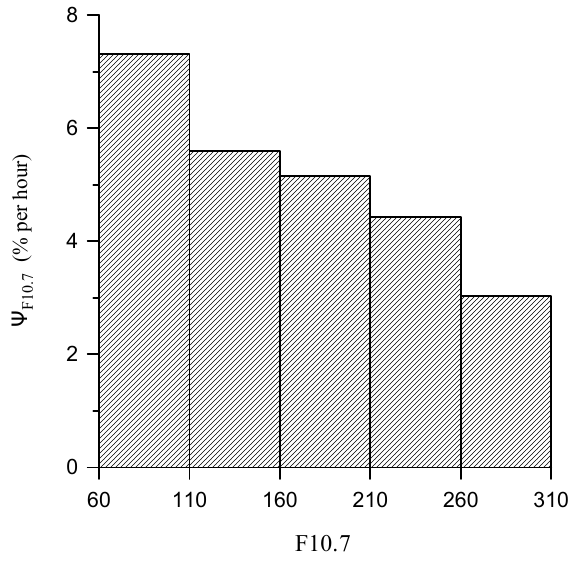
Fig. 2. The dependencies of the NETE occurrence probability 9 F10 . 7 on a daily solar activity index